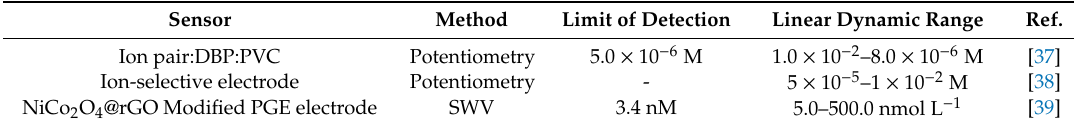
Table 5. A number of characteristics of the various electrodes (Ion-Selective Electrode, pencil graphite electrodes (PGE), etc.) in the VEN electrochemical